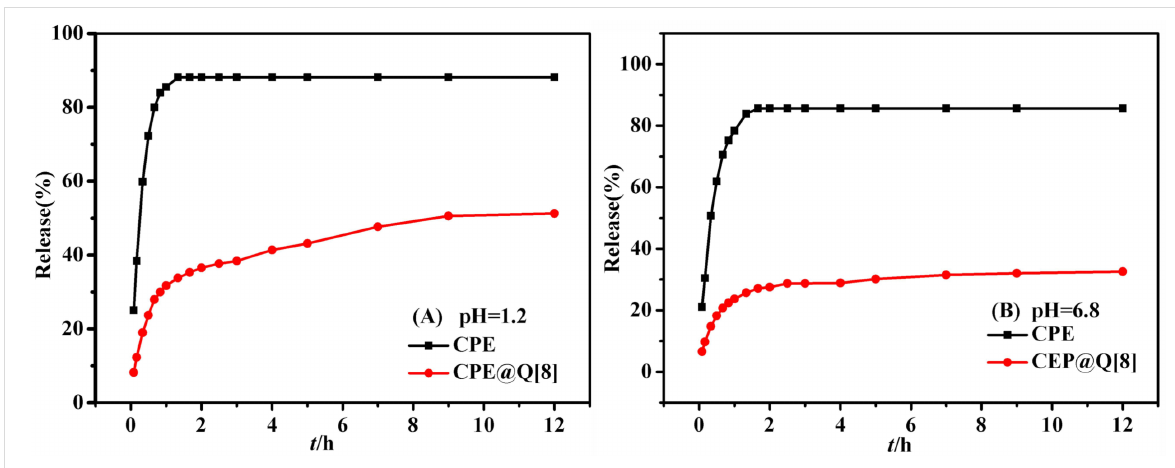
Figure 8: Release curve of CPE and CPE@Q[8] in artificial gastrointestinal juice (pH 1.2, pH 6.8).